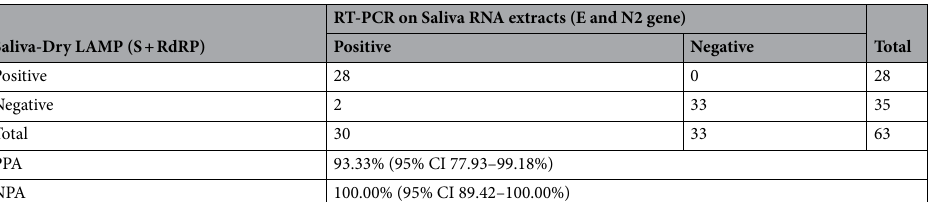
Saliva-Dry LAMP (S +